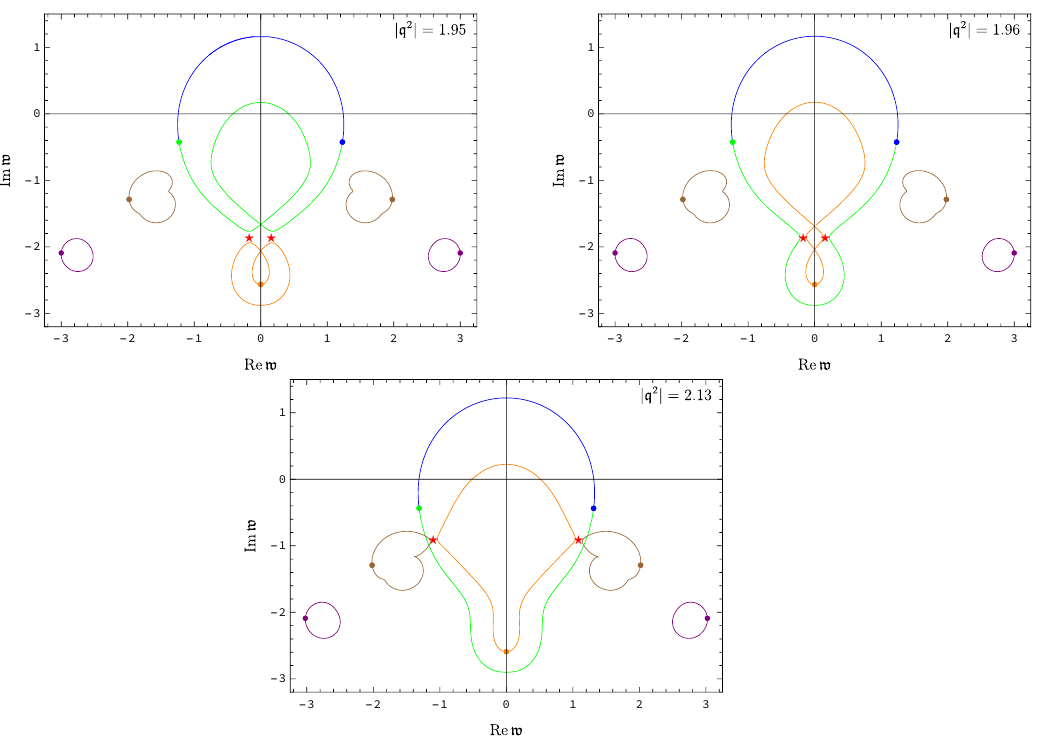
Figure 10 . Quasinormal spectrum in the sound channel at γ = 4 . 5 · 10 − 5 , computed non- perturbatively in γ